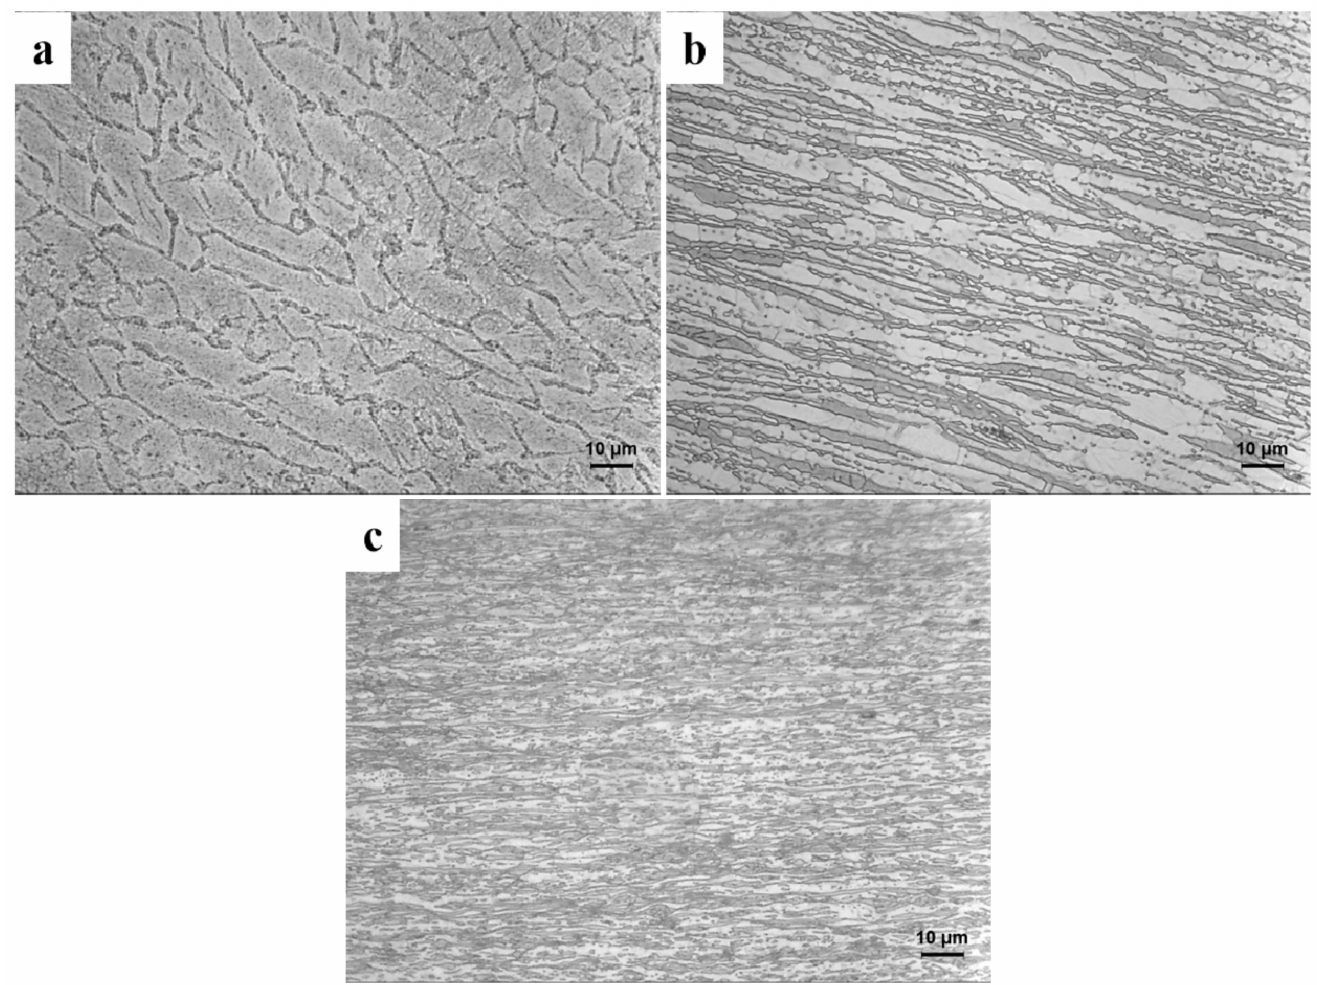
Figure 2. Optical images of the microstructure of the Zn-0.5%Li-0.1%Ag alloy in different treatment states: ( a ) as-cast, ( b ) extruded, and ( c )